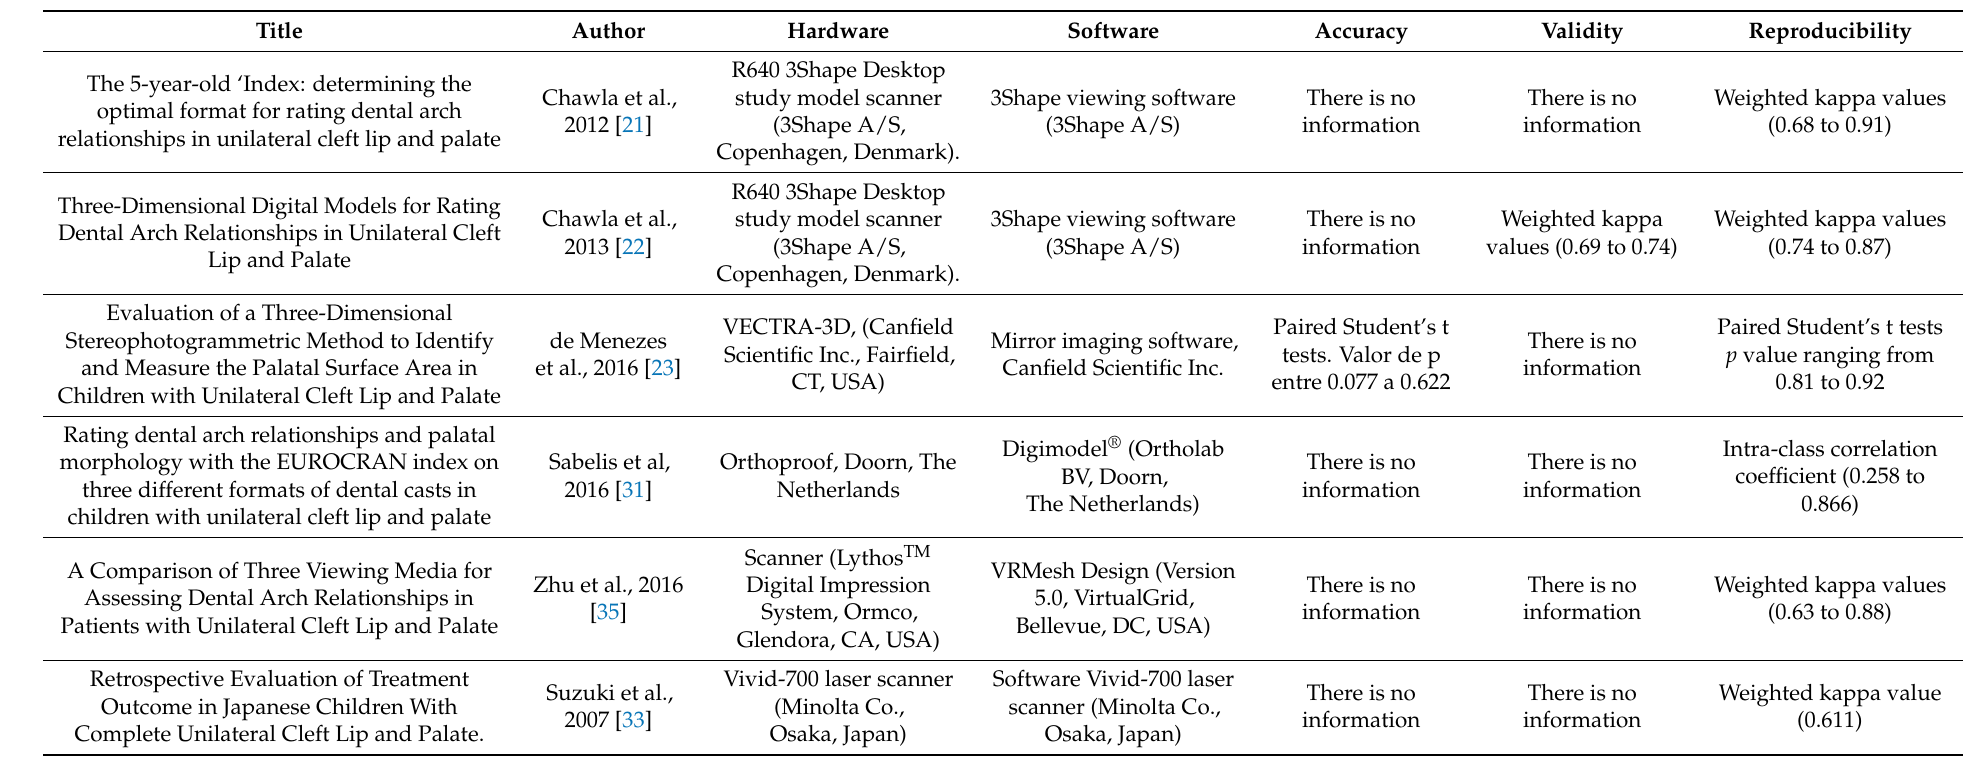
Table 4. Accuracy, validity, and reproducibility of the diagnostic